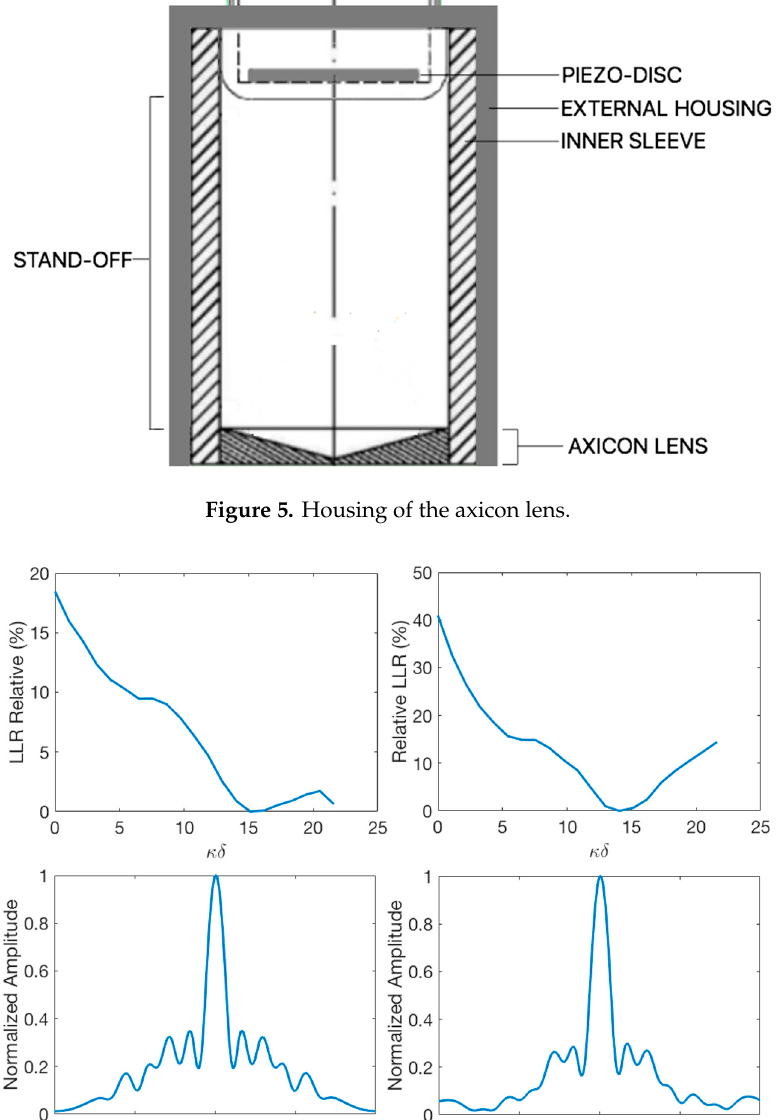
Figure 4. (Top) Value of F/N and (Bottom) relative loss of lateral resolution, both, vs. stand-off given in number of wavelengths ( κδ ) for 445 kHz PDMS-based axicon lens with different angles. ( a ) φ = 140°;